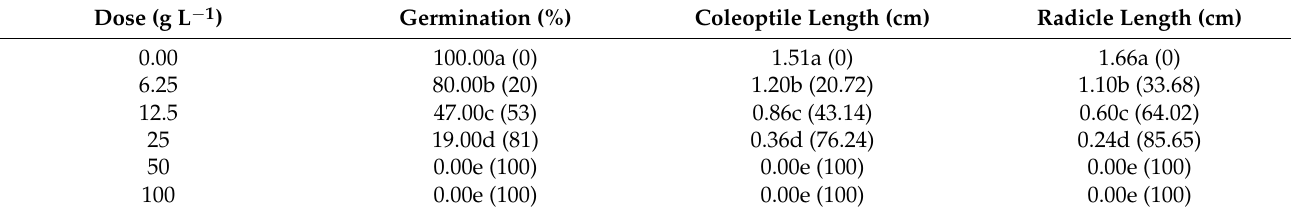
Table 1. Effects of P. hysterophorus on germination, coleoptile and radicle length of C.